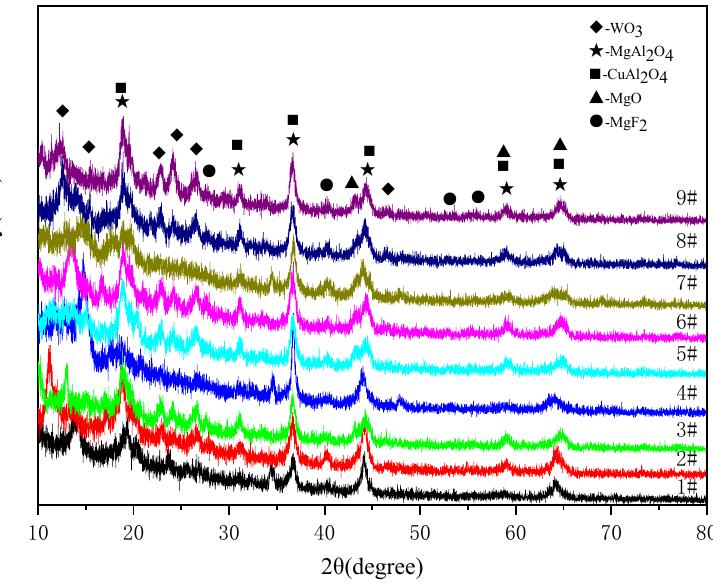
Figure 7. The XRD patterns of black MAO coating samples 1 # –9 # .